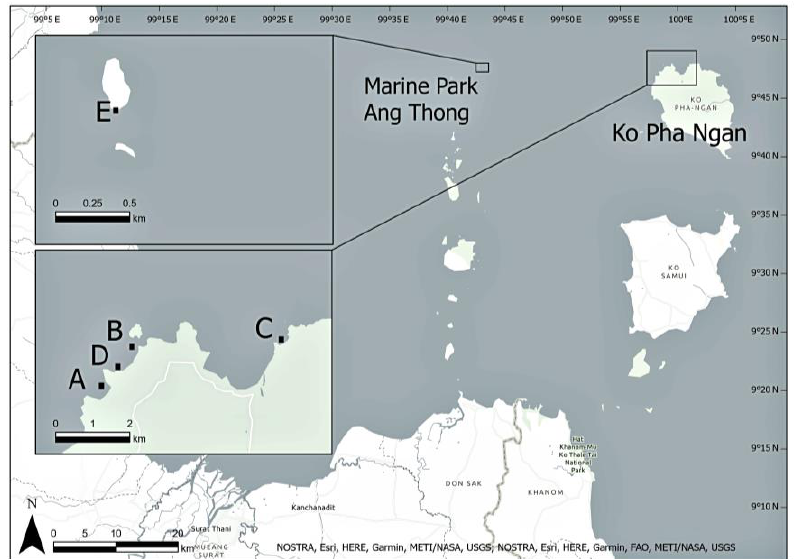
Figure 1. Map of study sites. (A) Haad Salad, (D) Mae Haad IV, (B) Mae Haad II, (C) Haad Khom and (E) Ang Thong Marine Park. and (E) Ang Thong Marine